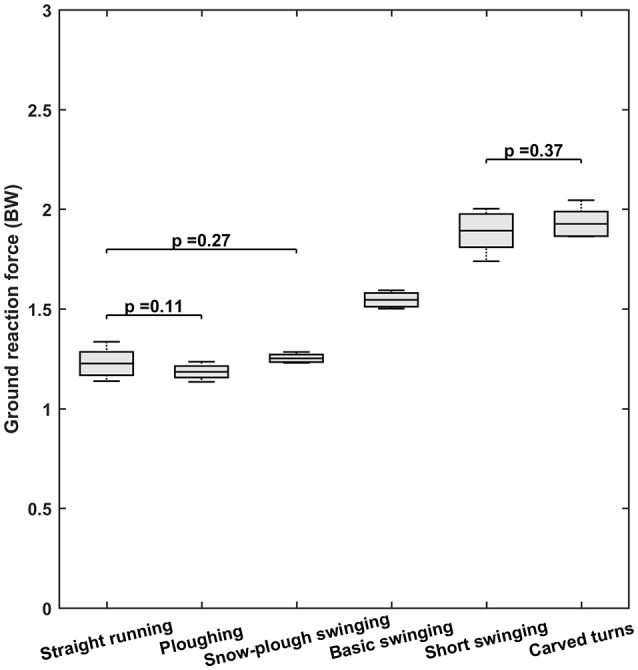
Peak ground reaction forces (GRF) for the six different types of skiing. In each box, the central line indicates the mean and the bottom and top edges the standard deviation. The whiskers extend to the maximal and minimal data points. Note that for more effective presentation, the p-values for pairs that did not differ significantly are the only ones shown.